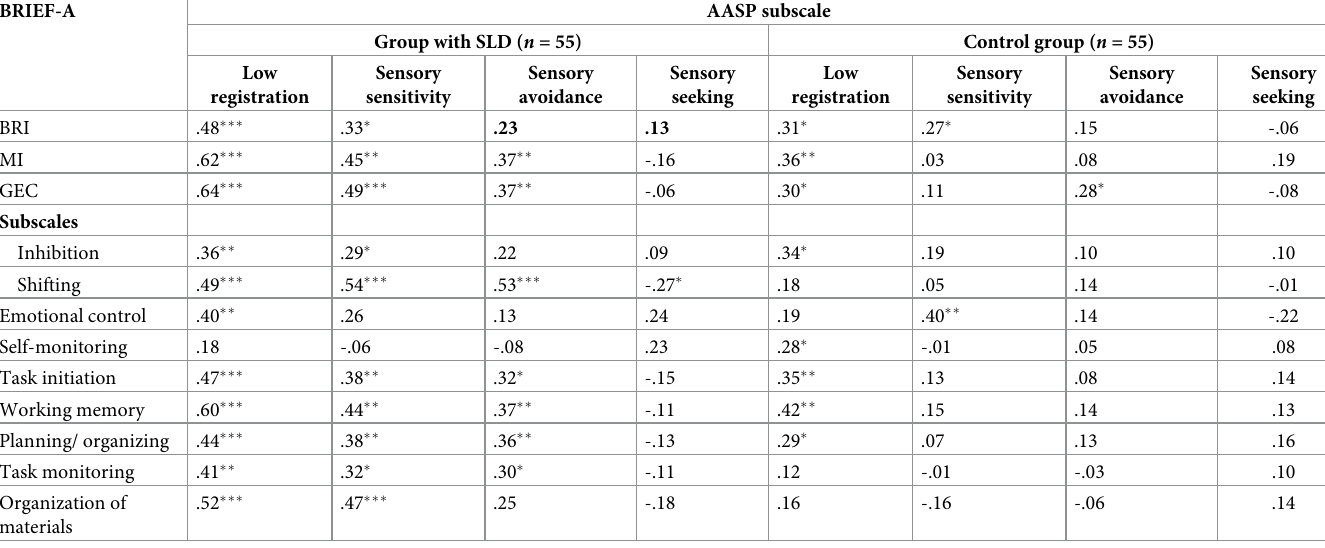
Table 1. Correlations between executive function (BRIEF-A) General and Subscale Scores and Sensory-Pattern (AASP) scores in each group.